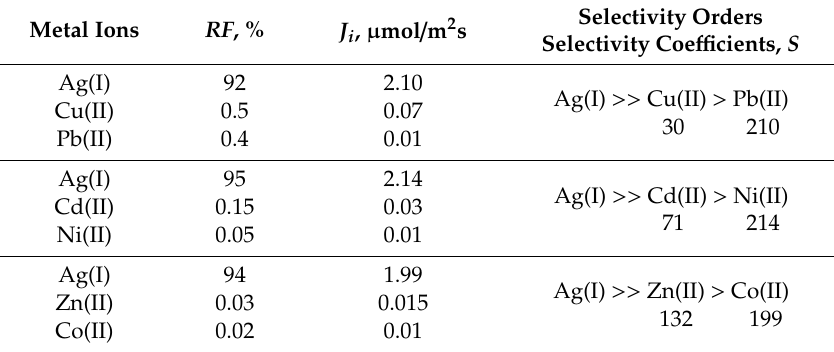
Table 1. The initial fluxes ( J i ) and selectivity orders and coe ffi cients (S M1 / M2 ) obtained in the transport of Ag(I), Cu(II), Pb(II), Cd(II), Ni(II), Zn(II), and Co(II) across PIMs. Source phase: 5.0 × 10 − 4 M of